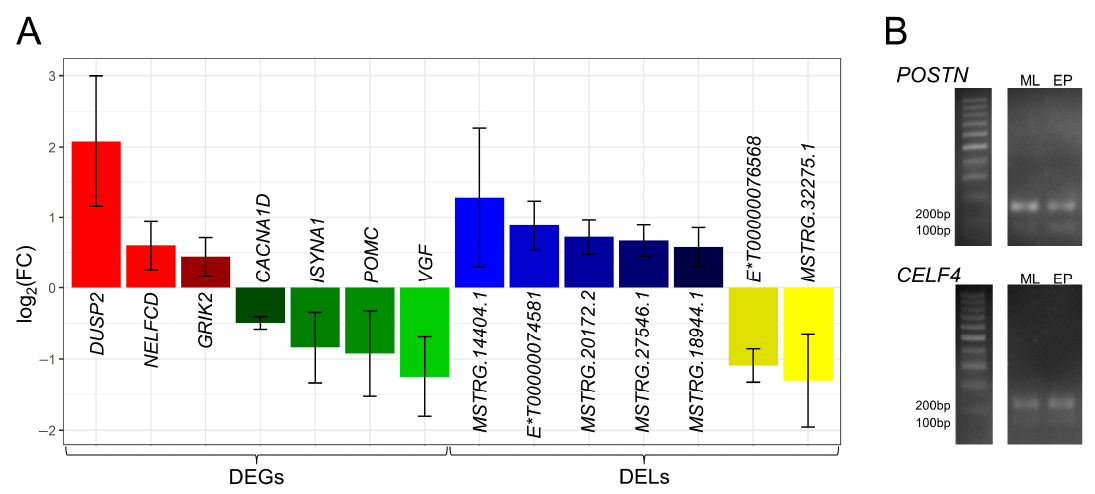
Figure 7. ( A ) Quantitative real-time PCR validations of RNA-Seq results performed for DEGs— CACNA1D , DUSP2 , GRIK2 , ISYNA1 , NELFCD , POMC and VGF —and DELs— ENSSSCT00000074581 , ENSSSCT00000076568 , MSTRG.14404.1 , MSTRG.18944.1 , MSTRG.20172.2 , MSTRG.27546.1 and MSTRG.32275.1 with reference genes, GAPDH and PPIA . All data are expressed as log 2 (FC) ± confidence interval (n = 5). Error bars not crossing the X -axis indicate that the corresponding means comparison is statistically significant to 5% in the Student’s t -test. ( B ) The PCR validation of differential alternative splicing events classified as skipping exon within CELF4 and POSTN . The PCR image shows inclusion and skipping exon levels in ML and EP groups. Abbreviations: bp—base pairs, DEGs—di ff erentially expressed genes, DELs—di ff erentially expressed long noncoding RNAs, EP—the embryo implantation period of pregnancy, log 2 (FC)—binary logarithm of fold change, ML—the mid-luteal phase of the estrous cycle.